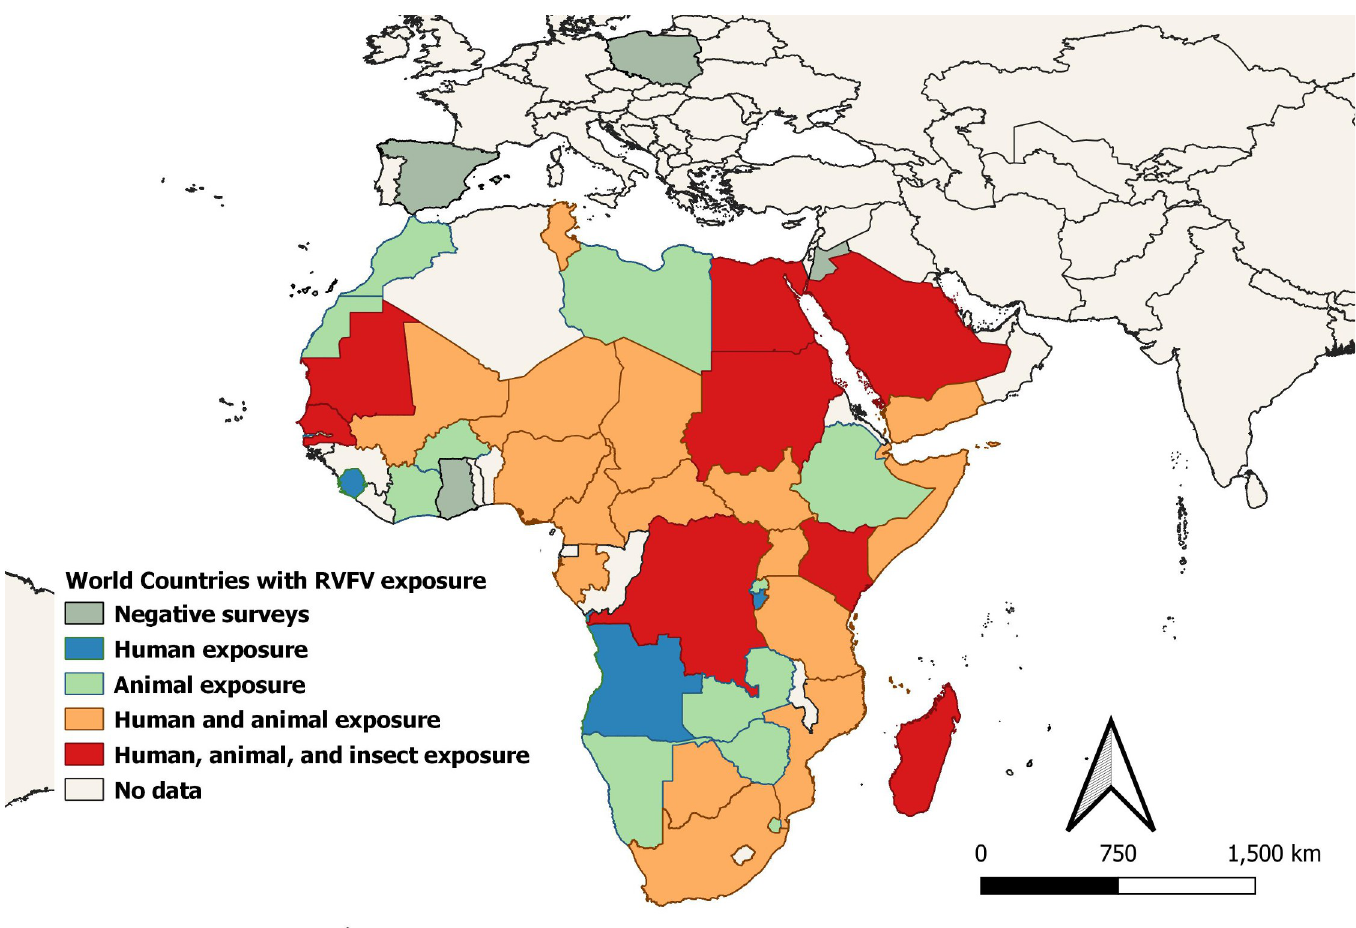
Fig 2. Regional map of countries exposed to RVFV infection based on findings of studies included in the systematic review. Countries were categorized as to whether there was evidence of human, animal, or arthropod RVFV infection during the 1999–2021 era. Base map is from Database of Global Administrative Areas (GADM) (version 3.4, (April 2018,